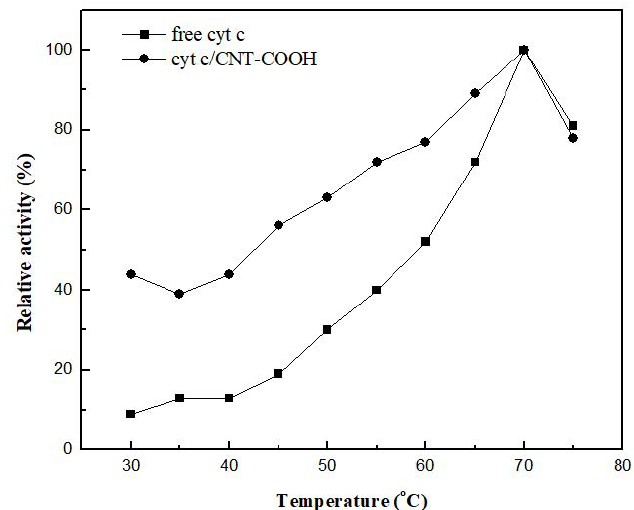
Fig. 1. Effect of temperature on the catalytic activity of free and non covalently immobilized cyt c. As 100% indicated the highest activity exhibited each time, either by free or immobilized cyt